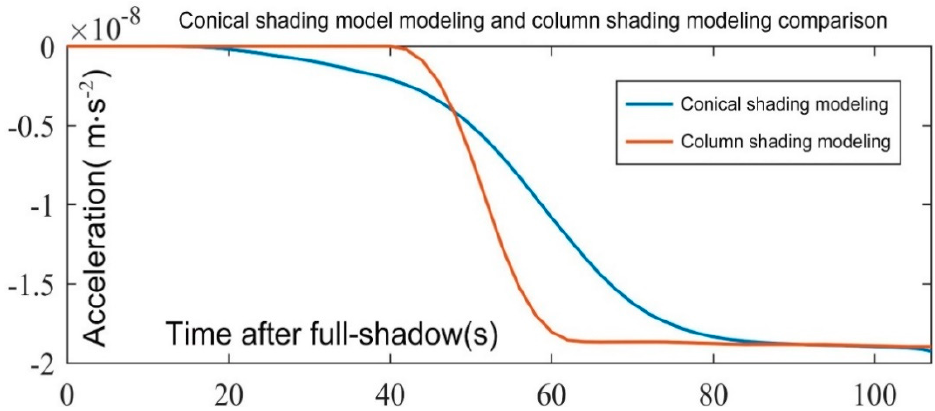
Figure 8. Comparison of conical shading model modeling and column shading modeling. As can be seen from Figure 8, the transition time from the full-shadow region to the shadow-free region is longer for the simplified cone-shadow model than for the column- shadow model. In the simplified conical shadow model, the Swarm-C satellite is in the full-shadow region during the 0–20 s, the Swarm-C satellite is in the penumbra region during 20–80 s, and the Swarm-C satellite enters the no-shadow region after the 80 s. Moreover, in the column shadow model, the Swarm-C satellite is in the full-shadow region during 0–42 s. After 62 s, the Swarm-C satellite enters the no-shadow region. For modeling the satellite surface light radiation pressure in the full-shadow and shadowless regions, the difference between the improved cone-shadow model and the column-shadow model is not significant. However, because the Sun’s rays are parallel rays in the column-shadow model, the model does not have the penumbra region, so the transition time of the Swarm-C satellite from the present shadow region to the shadowless region only lasts for about 20 s. In contrast, the transition time of the Swarm-C satellite from the penumbra to the no-shadow region in the conical shadow model lasts about 60